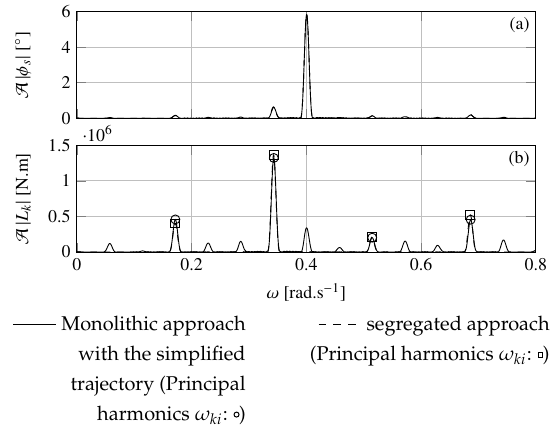
Figure 17. With a tether length L t = 840 m at the wave frequency ω w = 0.4 rad.s − 1 ; ( a ) Spectrum of the roll motion of the ship; ( b ) Spectrum of the kite excitation moment around the longitudinal ship